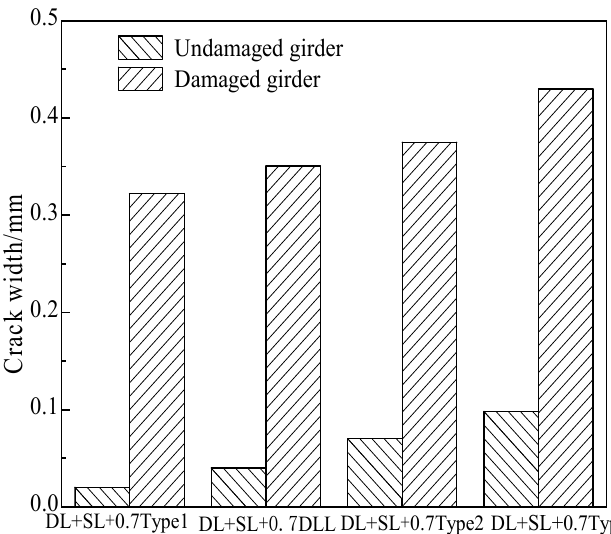
Figure 25. Crack width comparison due to the destructive tests.